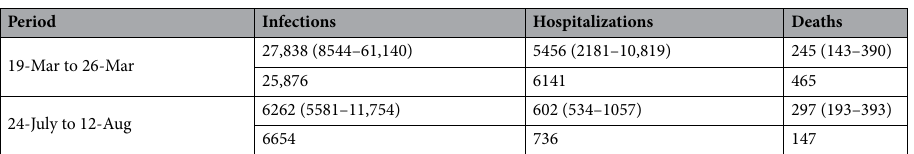
Table 4. Model predictions and reported accumulated infections, hospitalizations, and deaths for the periods 19 to 26-Mar-2020 and 24-July to 12-Aug-2020. Top rows represent predictions, while bottom rows are the reported cases. Between parentheses are the 90%